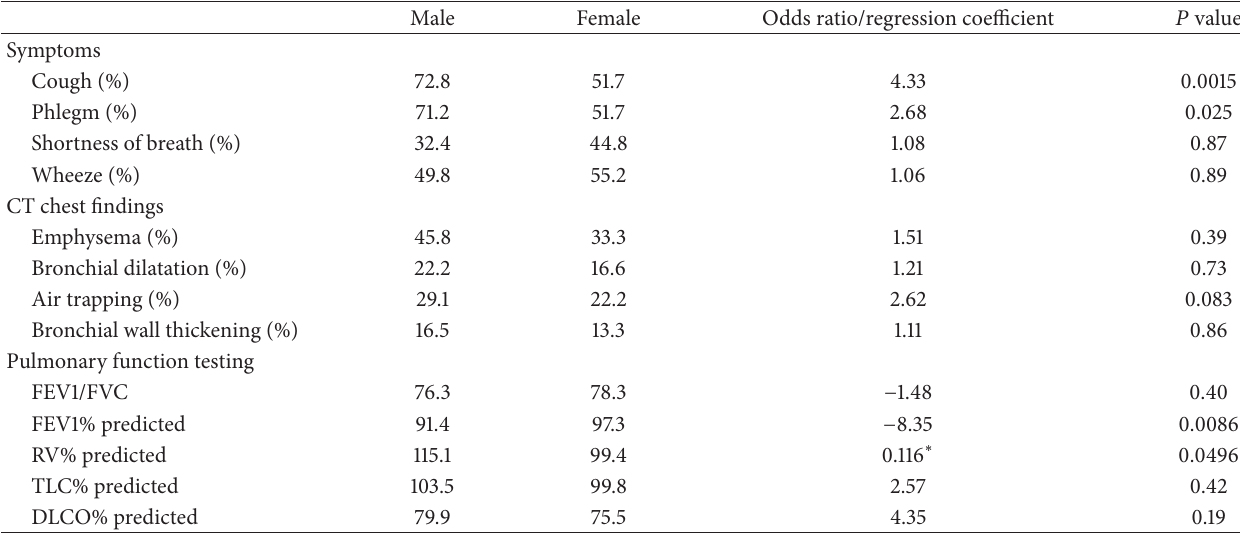
Table 2: Comparison of sex differences in respiratory symptoms, chest CT findings, and pulmonary function testing.